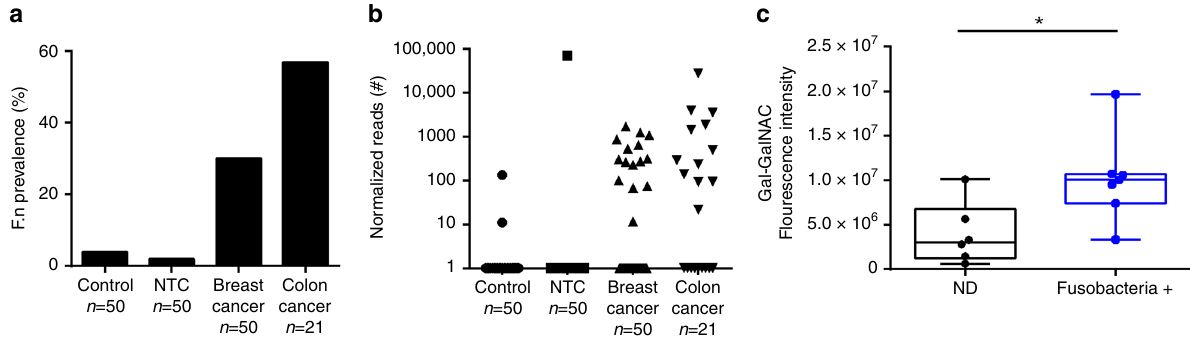
Fig. 2 F. nucleatum gDNA is overabundant in breast cancer displaying high Gal-GalNAc levels. a The prevalence of F. nucleatum in breast tumors ( n = 50) is shown and compared with DNA extraction controls (control, n = 50), PCR controls (NTC, n = 50), and colon tumors ( n = 21). b Normalized read count (reads normalized to the average number of reads across different libraries) of F. nucleatum in each of the above samples (each dot represents the read counts of F. nucleatum in the sample) is shown (control n = 50, NTC n = 50, breast cancer n = 50, colon cancer n = 21). c Gal-GalNAc levels (measured using FITC-labeled PNA) in F. nucleatum -containing breast cancer samples (Fusobacteria + , n = 7) and in the samples in which F. nucleatum gDNA was not detected (ND, n = 6). * p = 0.0221, two-tailed Mann – Whitney test. Source data are provided as a Source data fi